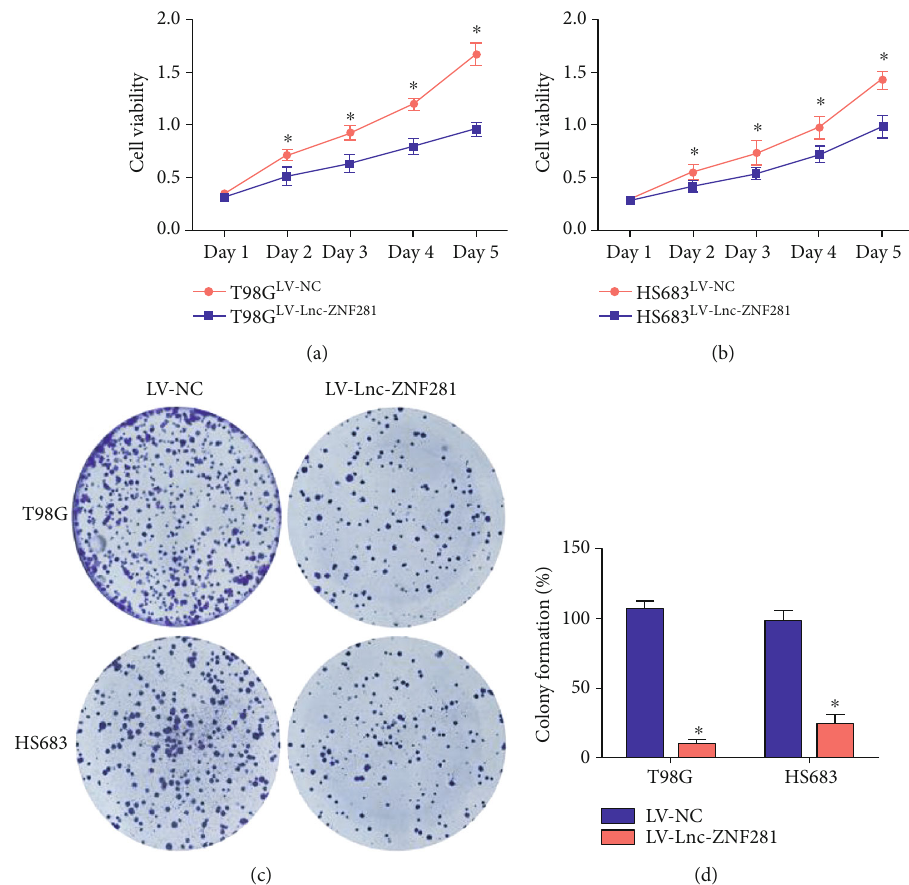
Figure 2: Overexpression of lnc-ZNF281 inhibited glioma cells proliferation. (a, b) The CCK-8 assay results indicated that overexpression of lnc-ZNF281 prevents the growth rate of glioma cells. (c, d) Cell colony formation assay results indicated that overexpression of lnc-ZNF281 inhibited the proliferation of glioma cells. ∗ p < 0 : 05